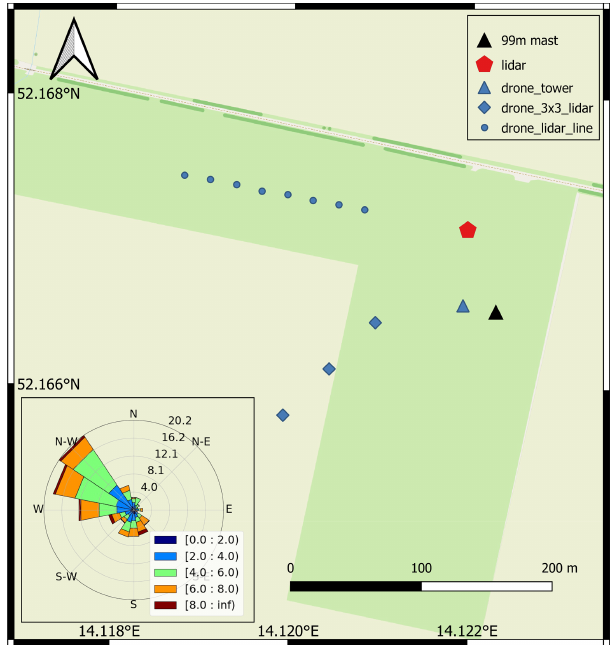
Figure 2. Map of the experiment site, including the locations of UAV fleet measurements. © OpenStreetMap contributors